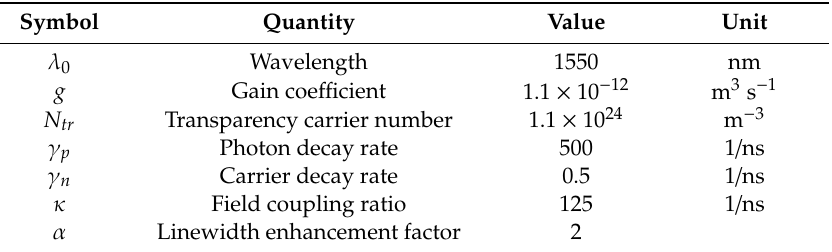
Figure 5. Injection ‐ locking maps as a function of detuning frequency and injection ratio showing (a) amplitude modulation (AM) and (b) phase shift of the injection ‐ locked laser. amplitude modulation (AM) and ( b ) phase shift of the injection-locked laser. Table 1. Simulation